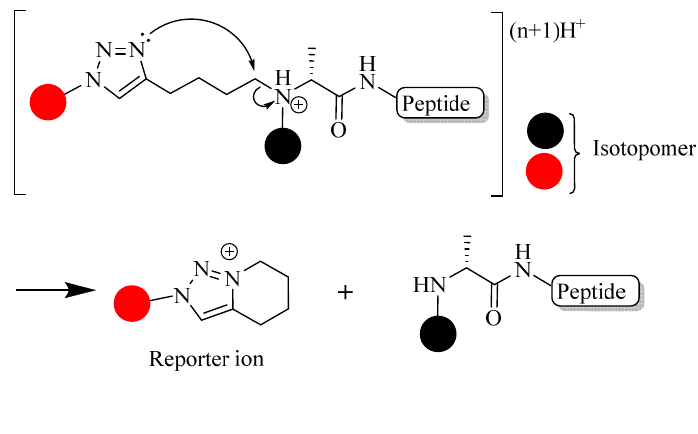
Figure 17. Gas phase fragmentation of triazole into reporter